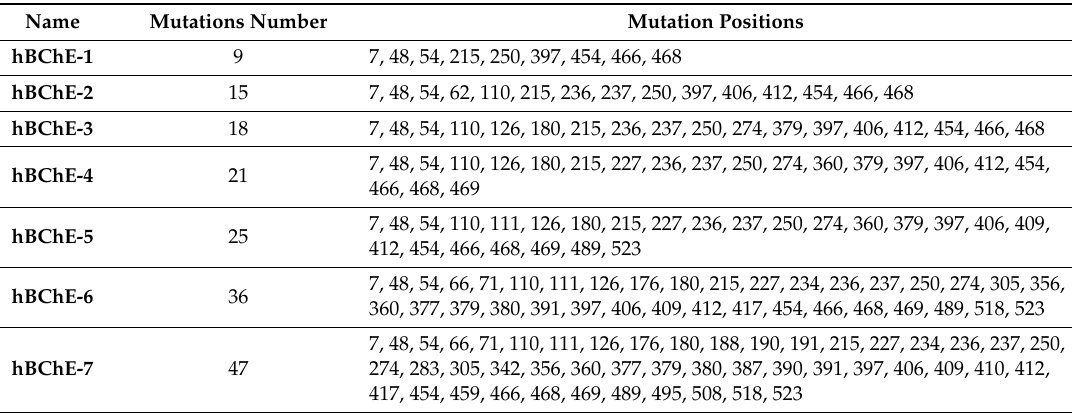
Table 2. Mutations number and positions of the seven human BChE constructs generated by the PROSS process. Positions are numbered from the physiologically maturated protein.